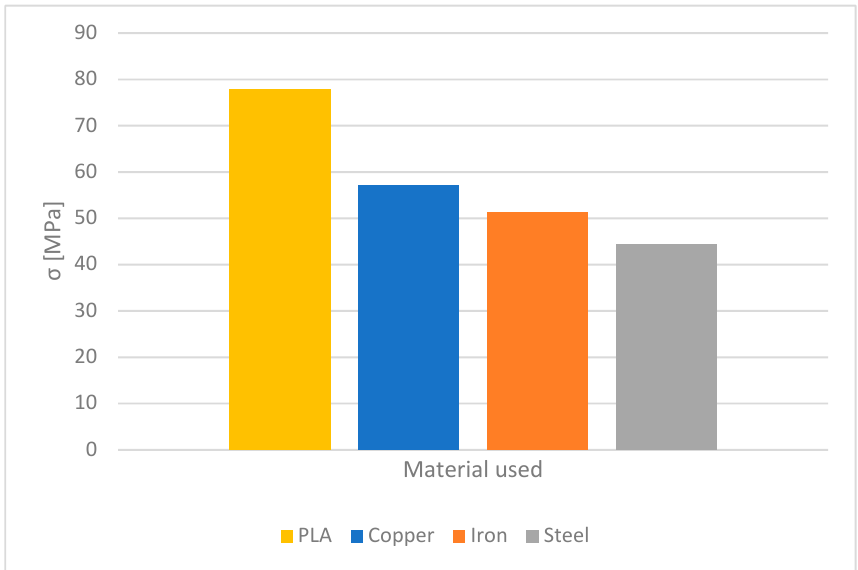
Figure 16. Maximal stress values for samples from different materials.